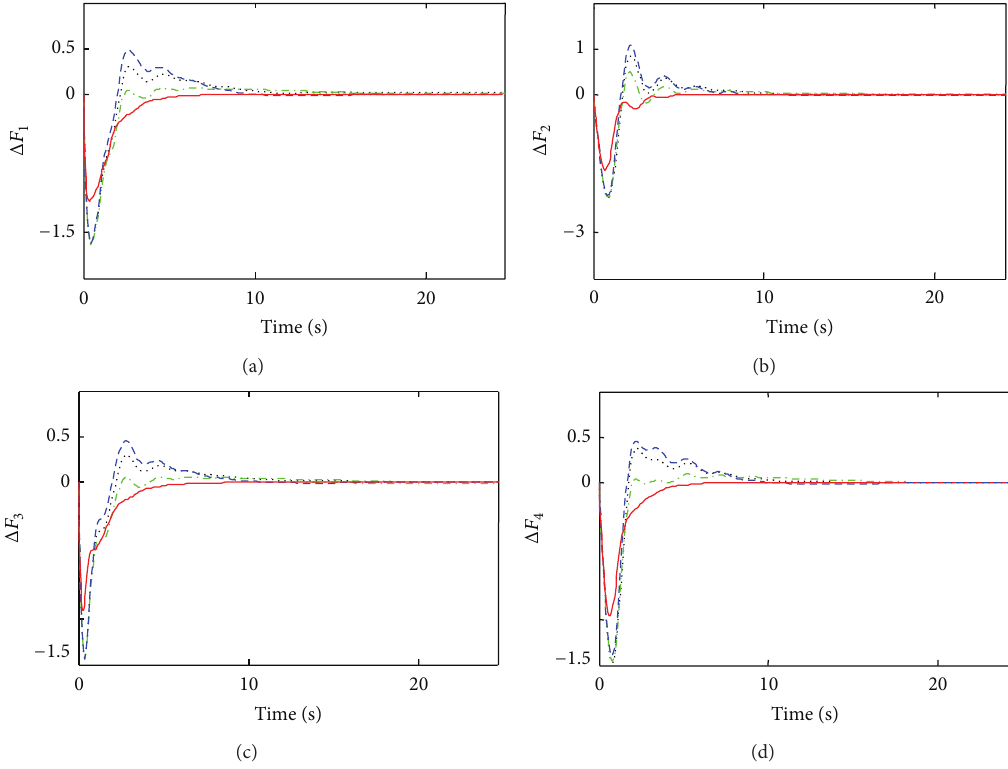
Figure 10: Deviation of frequency; (a) area 1, (b) area 2, (c) area 3, and (d) area 4 for +0% change of parameters; Solid (IABC), Dashed (HPSOCFA), Dashed Dotted (RGA), and Dotted